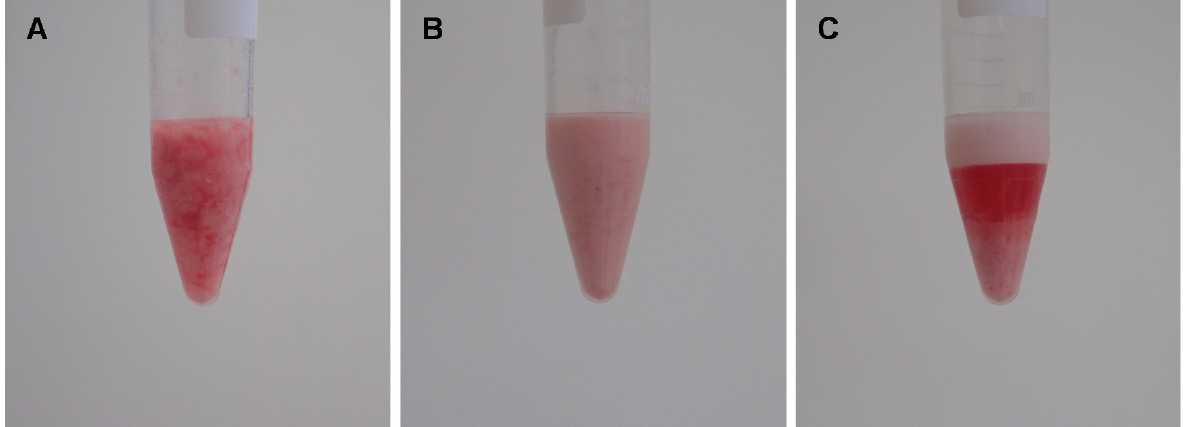
Figure 1. Creating mSVF by a combination of emulsification and centrifugation. Adipose tissue of male Sprague Dawley rats was harvested from both inguinal fat pads. ( A ) After removing connective tissue and blood vessels, the fat was finely minced. ( B ) Minced fat was shifted thirty times through a 1.2 mm tunnel to emulsify fat. ( C ) Emulsified fat was centrifuged, the mSVF is the bottom layer.